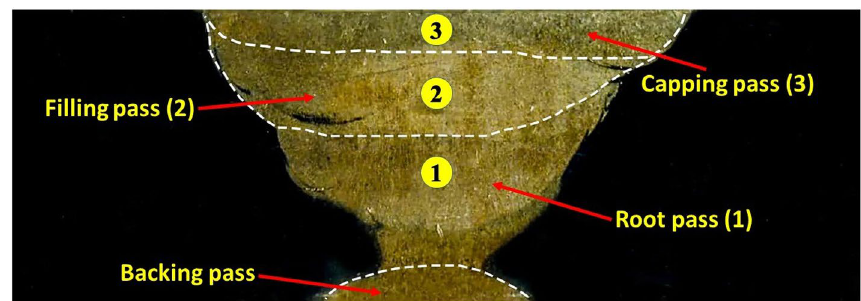
Figure 2. Macro section of a welded joint showing the sequences and the number of different passes.